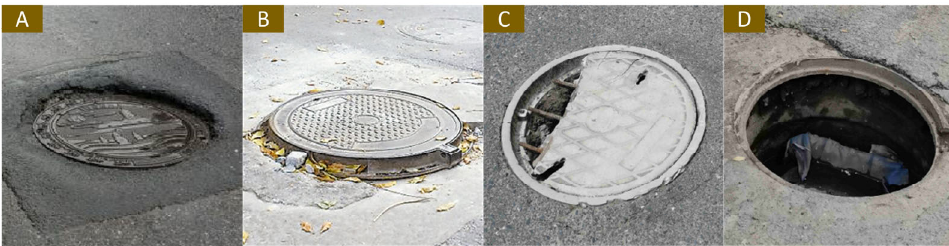
Figure 5. Example of three categories of abnormal manhole covers: ( A , B ) denote “Dislocated”, ( C ) denotes “Damaged”, and ( D ) denotes “Missing”. Table 2. Classification of manhole covers and the quantity of various covers